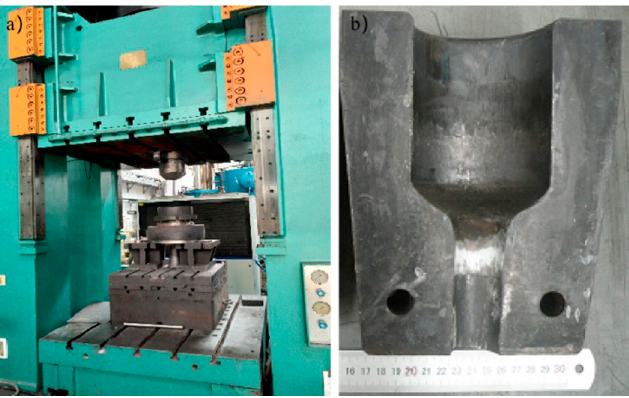
Figure 1. Hydraulic press and die used in extrusion experiments: ( a ) The 1600 t hydraulic press; ( b ) The extrusion die. ( b ) The extrusion